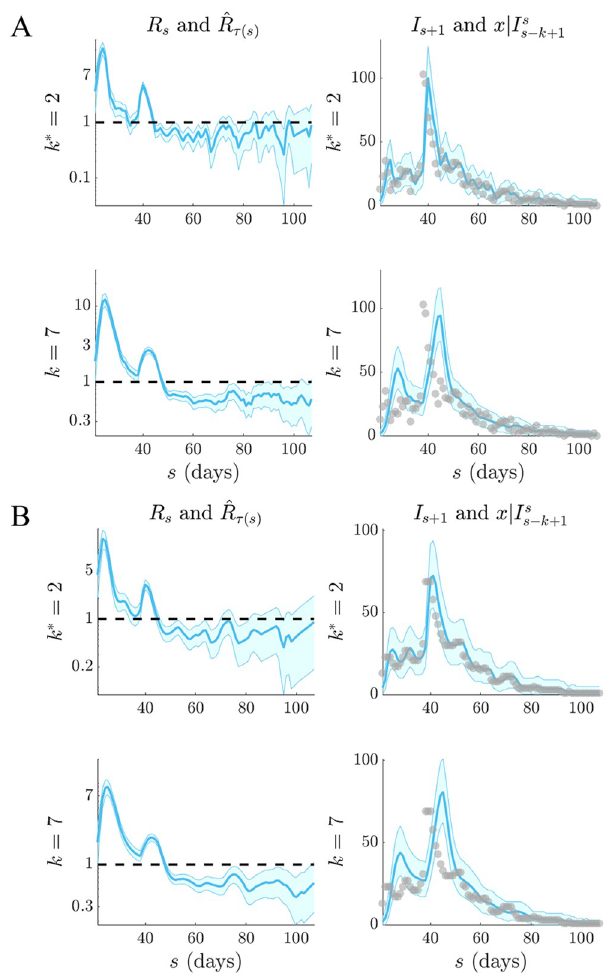
Fig 10. Selection for SARS (2003). Left graphs compare ^ R estimates (blue with 95% confidence intervals) at optimal t ð s Þ APE window length k � to weekly sliding windows ( k = 7), which were recommended in [10]. Right graphs give (blue with 95% prediction intervals). Dashed lines are the R = 1 corresponding one-step-ahead predictions x j I s s (cid:0) k þ 1 threshold (left) and dots are the true incidence I s (right). Panel (A) directly uses the empirical SARS (2003) data [10] while (B) smooths outliers (with a 5-day moving average) in the data as in